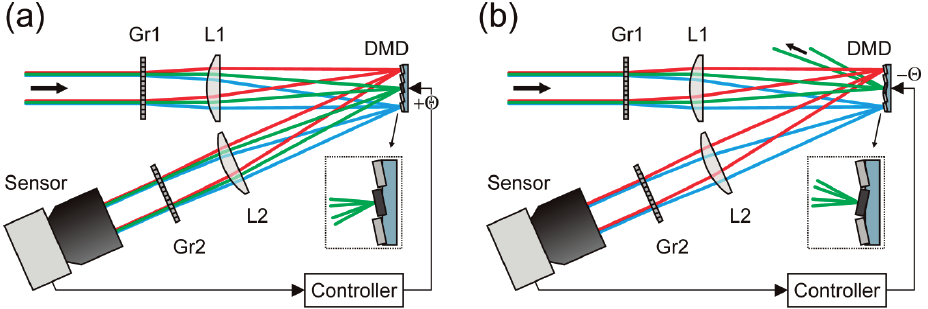
Figure 1. Scheme of a laser dazzling protection concept using a DMD. ( a ) Operation mode for regular imaging: all micromirrors are tilted towards the sensor. ( b ) Operation mode with high attenuation for dazzling light: the micromirrors which are exposed with dazzling laser light (here: the green rays) are tilted away from the sensor. Thus, the dazzling light will be strongly attenuated in the regular imaging